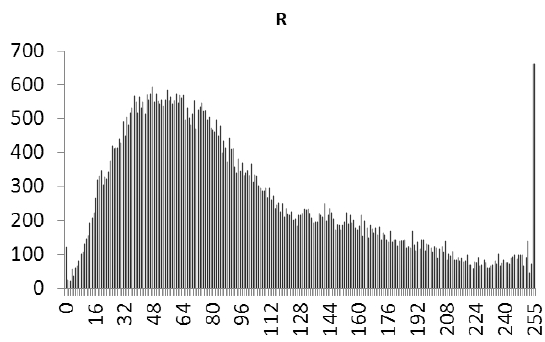
Figure 26. Statistical chart of R value distribution of the original image.